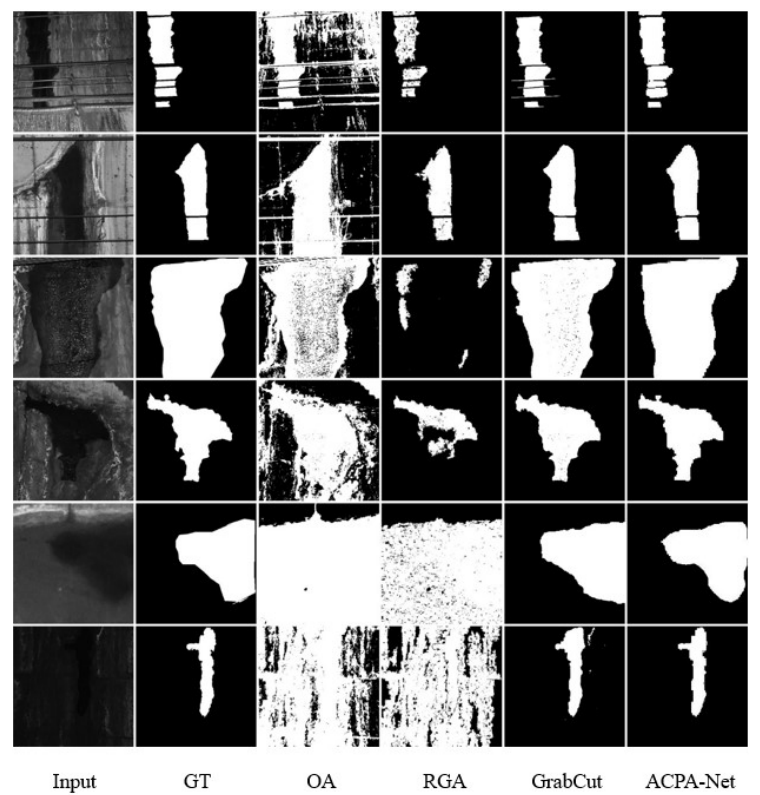
Figure 6. Visualization of inferenced results obtained by OA, RGA, GrabCut, and ACPA-Net on test set.